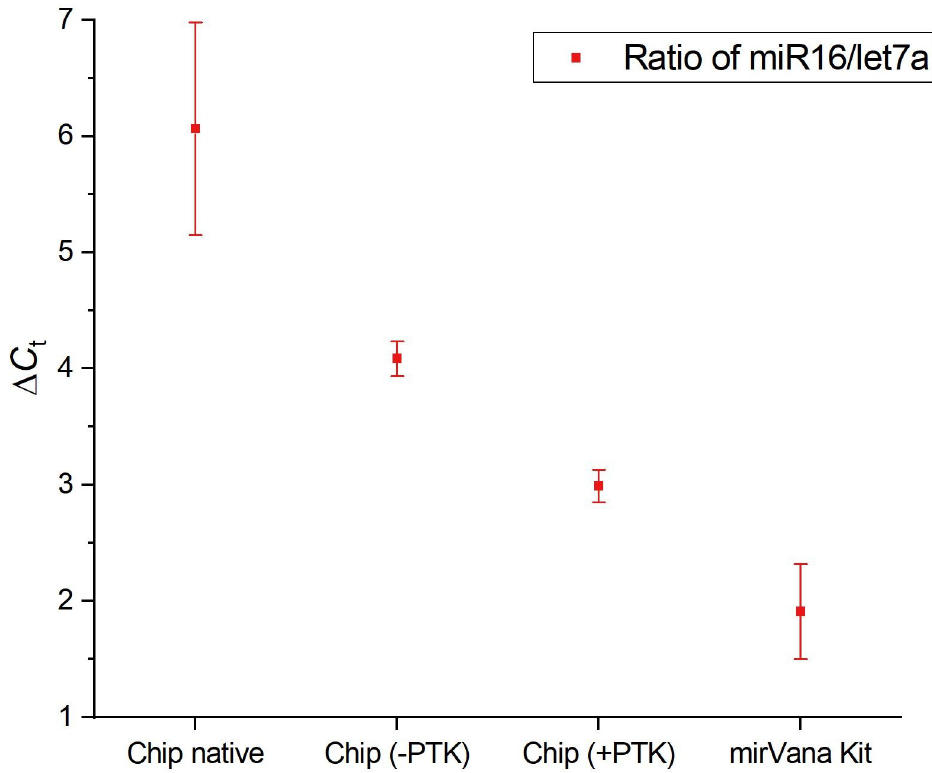
Fig 8. Comparison of miR16/let7a ratios. Chip native: Thermo-electric on-chip lysis and gel-electrophoresis. Chip (-PTK): Off-chip lysis by heat shock and on-chip gel-electrophoresis of the crude lysate. Chip (+PTK): Off-chip lysis by heat shock, proteinase K digestion and on-chip gel-electrophoresis of the digestion product. mirVana Kit: miRNA extracted by the mirVana kit (n = 3).